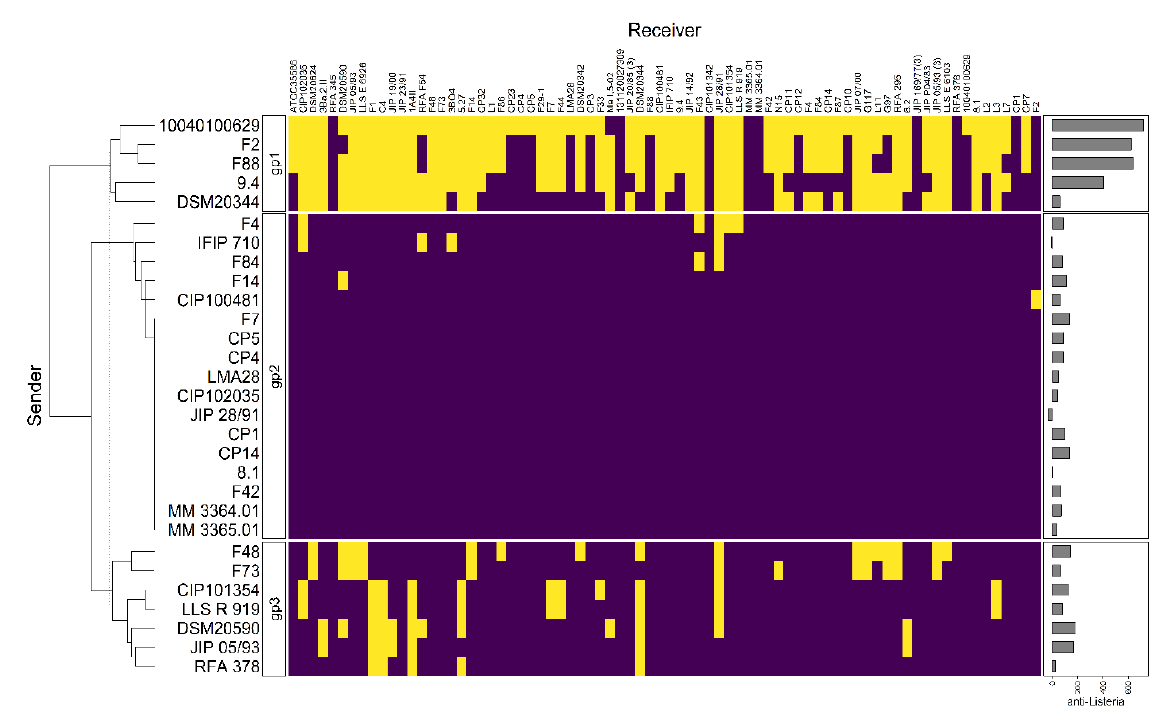
Figure 3. Hierarchical clustering analysis of the sender strains. The sender strains subjected to genome analysis in this study (in rows) were clustered based on their inhibition profiles of the C. maltaromaticum receiver strains (in columns). Yellow cells represent inhibition, purple cells non-inhibition. The clustering divides the senders into three groups, noted “gp1”, “gp2”, and “gp3”. The barplot annotation on the right represents the quantitative inhibition of L monocytogenes EGDe (in min) by the sender strains.